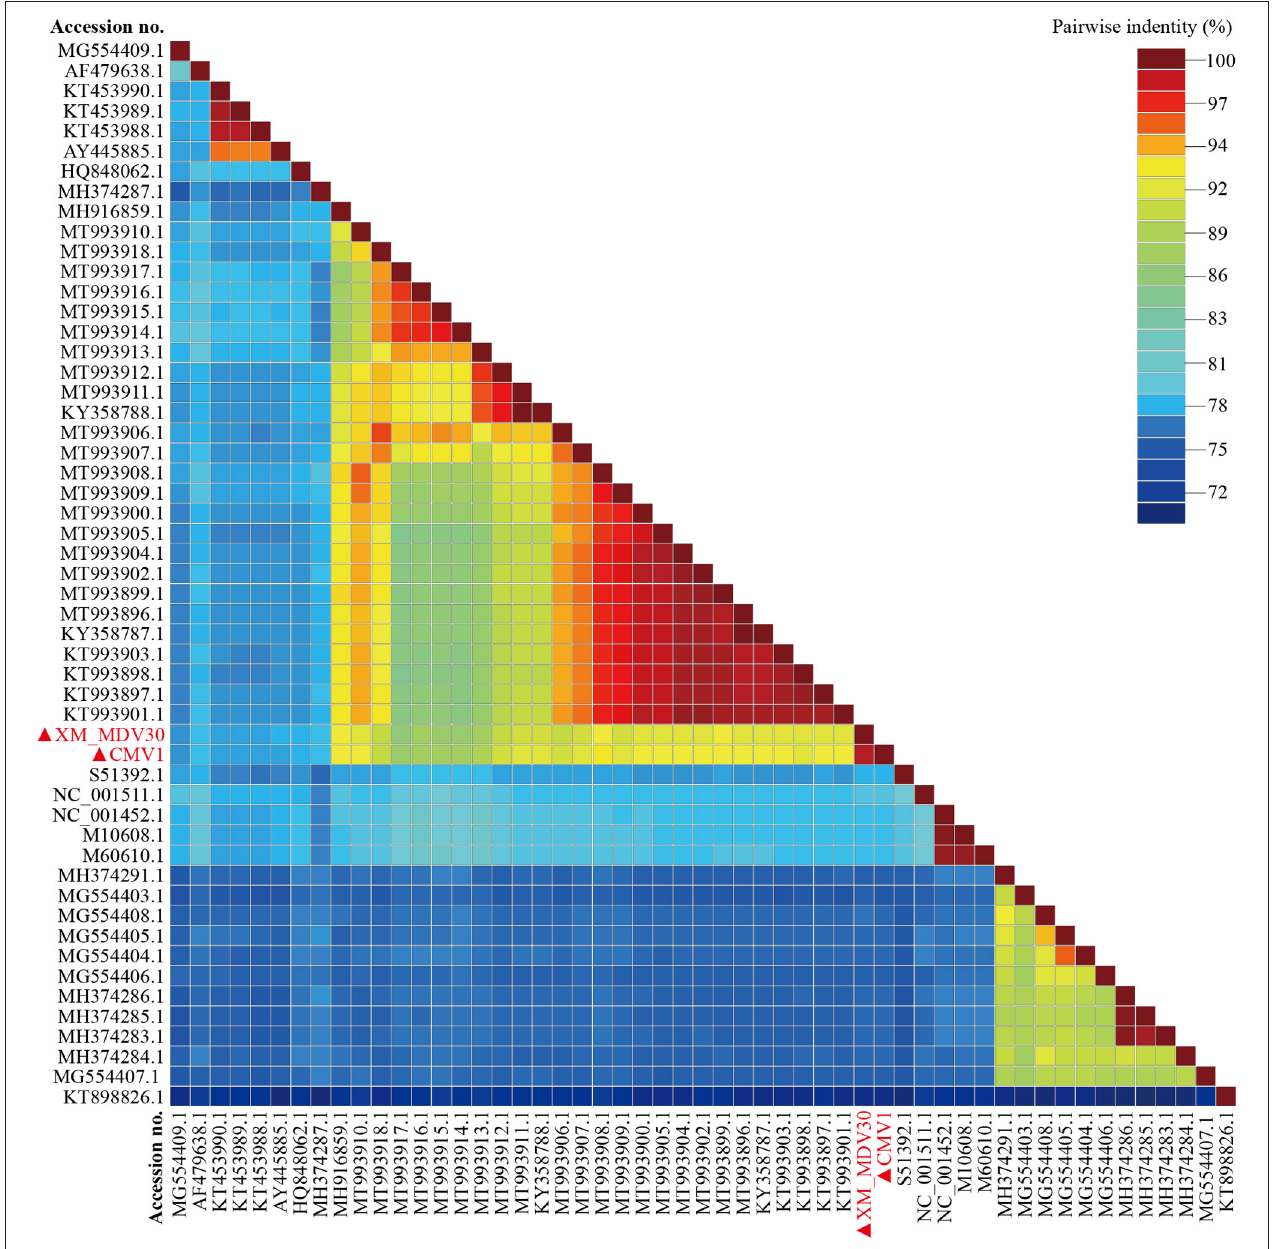
FIGURE 5 | Pairwise whole-genome identity matrix of Visna/Maedi virus strains. The genome sequences only recruited the VMV-like strains (SRLVs genotype A). The VMV genomes sequenced in this study are marked with black